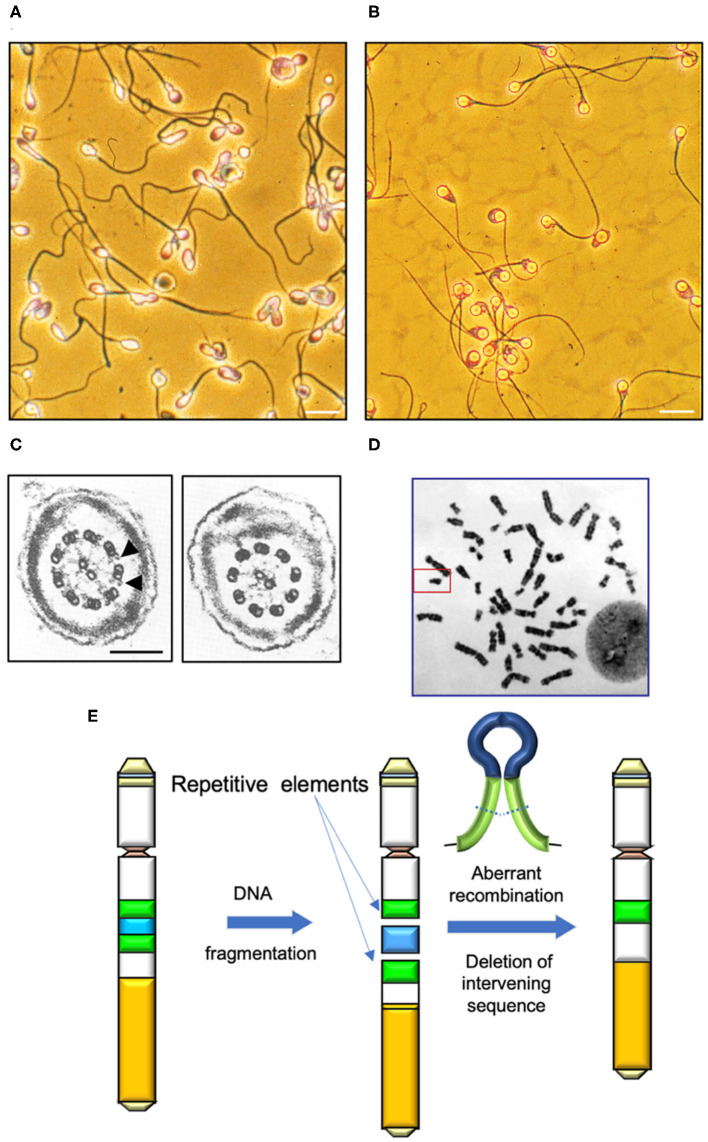
Determinants of human sperm quality. (A) Micrograph of a typical human sperm population. Note the significant inter-cell variation in morphological appearance of the sperm head, midpiece and tail. Morphological assessments are generally couched in terms of percentage normal cells, however defining the precise attributes of “normal” in this context is difficult. Scale bar = 10 μm. (B) A clearly abnormal condition is “globozoospermia” characterized by round headed, acrosome-less cells that are incapable of fertilization even though their motility is normal (10). Scale bar = 10 μm. (C) In contrast, Kartgener syndrome is a genetically-determined condition associated with major defects in the axoneme and complete immotility. Left panel cross section through a normal sperm tail highlighting the dynein arms (arrowed); right panel shows a section through the axoneme of a Kartagener syndrome patient, showing the complete absence of dynein arms (11). Scale bar = 200 nm (D) Human karyotype with the Y-chromosome, framed. (E) Major mechanisms by which DNA fragmentation on the Y is induced is through the aberrant recombination of repetitive elements (green) and deletion of the intervening DNA (blue).